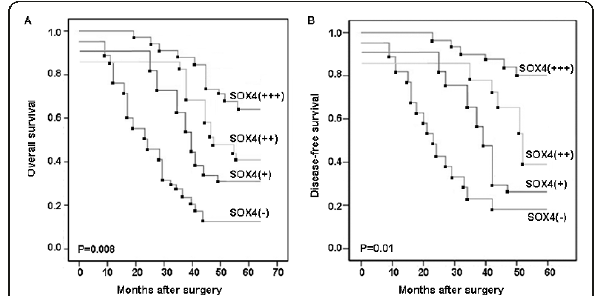
Figure 2 Overall survival (A) and disease-free survival (B) in 136 patients with PGC according to the expression levels of SOX4 . The analysis with Kaplan-Meier method clearly showed that PGC patients having tumors with strong SOX4 expression (+++) had respectively increased overall ( P = 0.008) and DFS ( P = 0.01) compared with patients with negative (-), weak (+) or moderate (+ +) SOX4